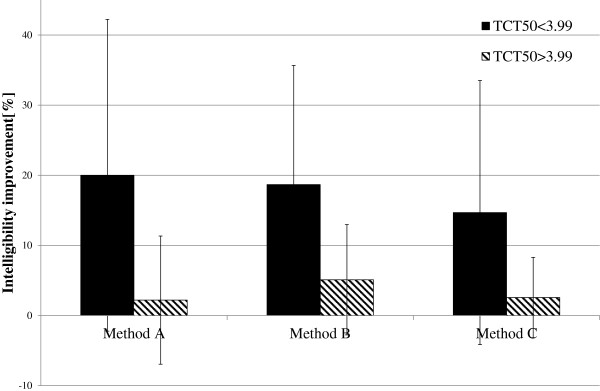
Average improvement in WER for input speech with average rate equal to ROSmean3.